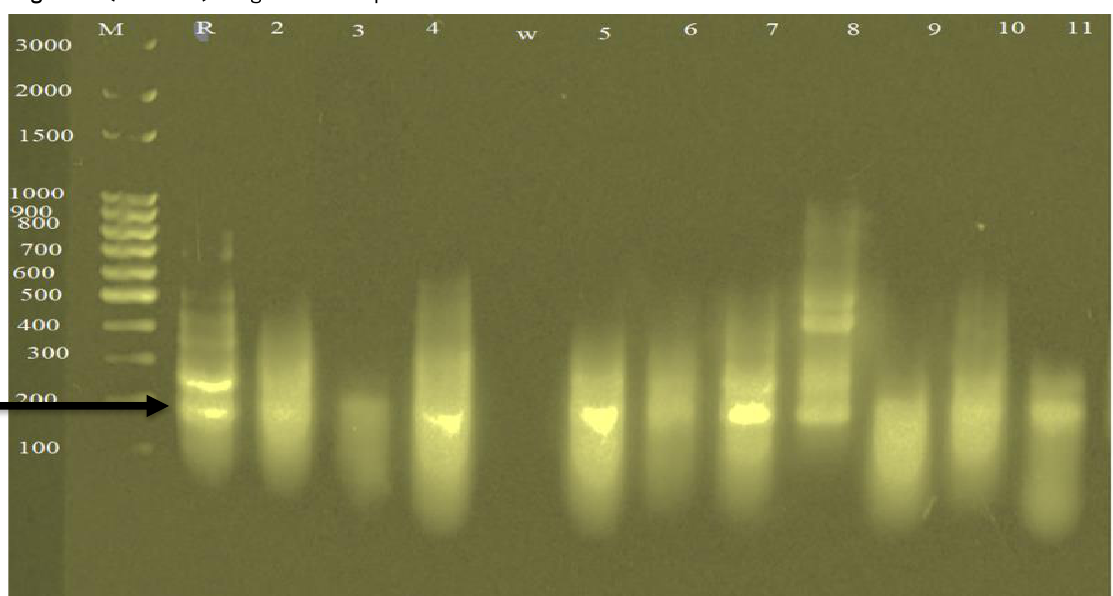
and 7 (environmental Pseudomonas spp ) and w (water